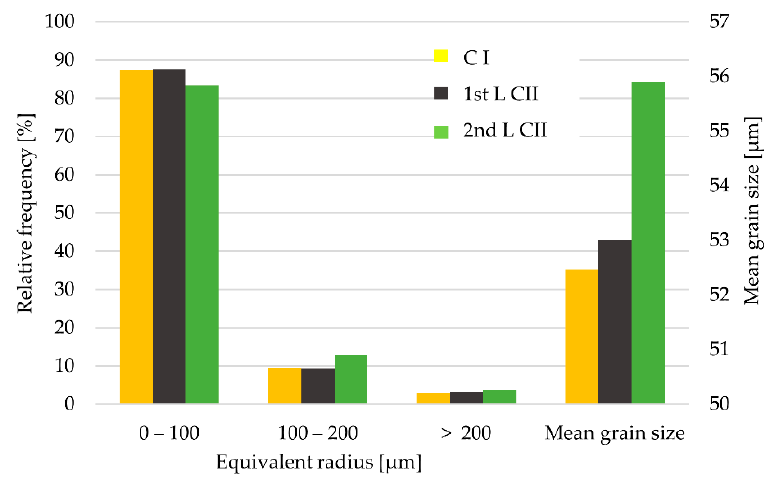
Figure 12. Distributions of grain size for clad I (C I) and the first and second layers of clad II (1st L C II and 2nd L C II, respectively), as determined by the equivalent radium method.